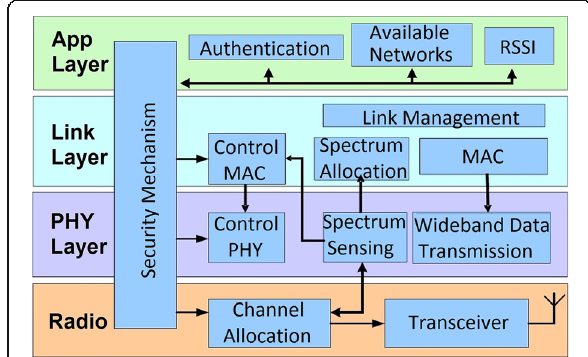
Fig. 3 Proposed cross-layer design for security in cognitive radio networks, adapted from